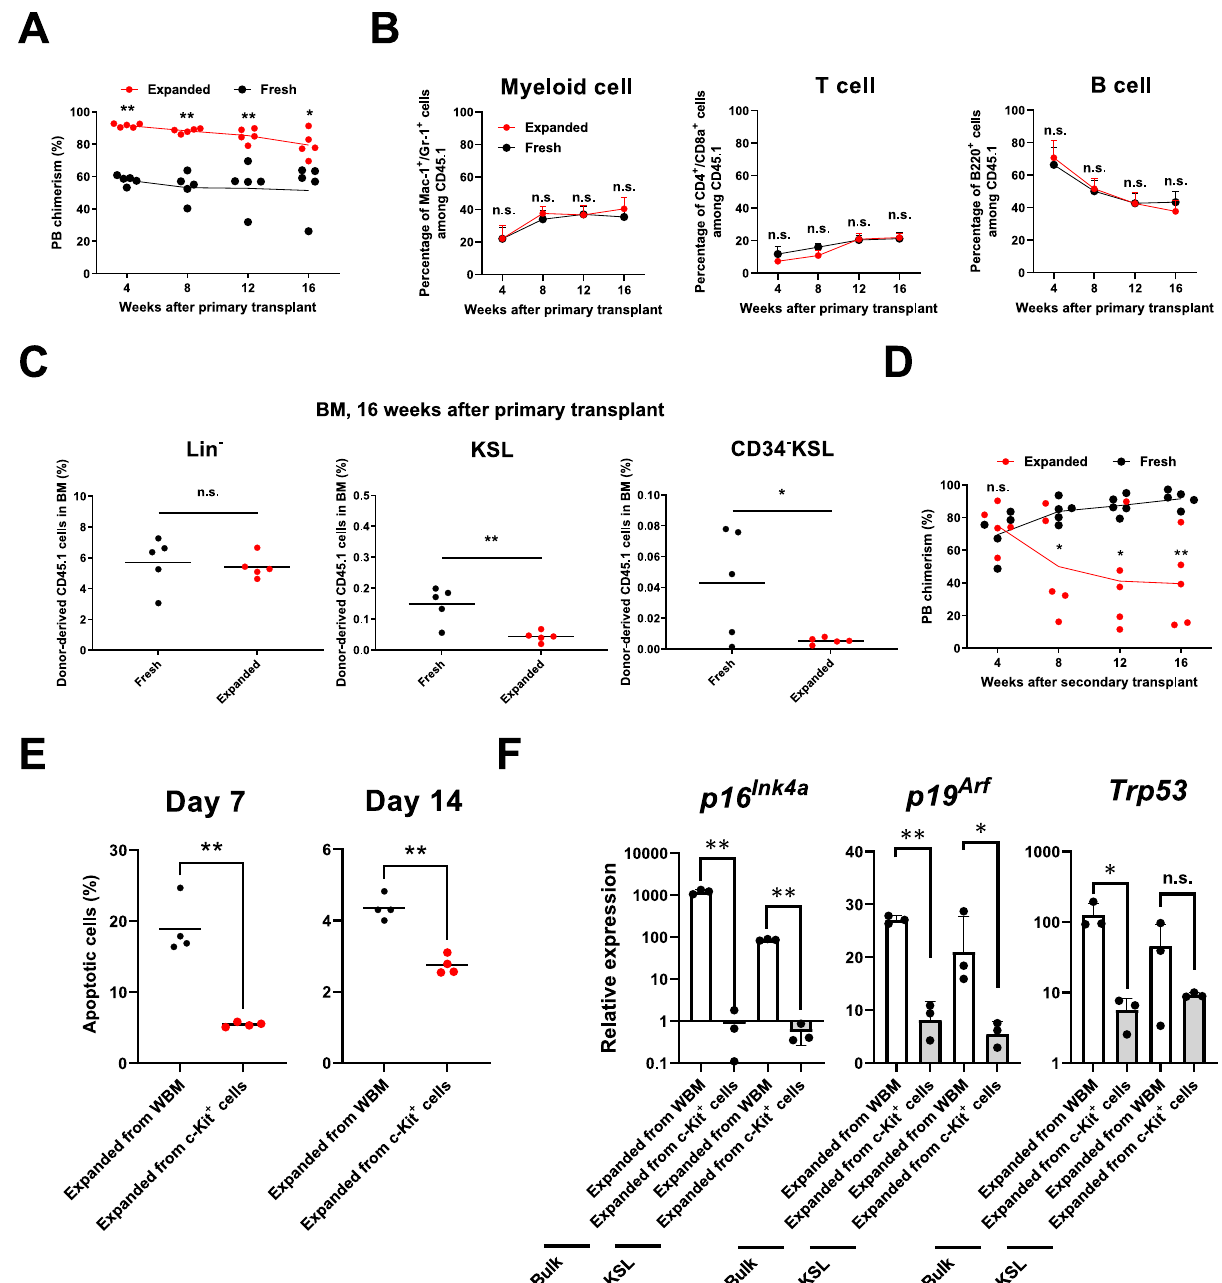
Fig. 2 Ex vivo enrichment of HSPCs from whole BM cells. A Percentage of donor-derived CD45.1 + cells in primary transplant recipients over time ( n = 5 mice per group) following competitive transplantation of 1 × 10 6 fresh or 28-day cultured whole BM cells (same transplantation protocol as detailed in Fig. 1A). ** p < 0.0001 at week 4, ** p < 0.0001 at week 8, ** p = 0.0013 at week 12, * p = 0.0114 at week 16. B Percentage of Mac-1 + /Gr-1 + (myeloid cells), CD4 + /CD8a + (T cells), and B220 + (B cells) among donor-derived CD45.1 + cells in primary transplant recipients over time for the mice described in A . Mean ± SD from 5 primary recipients ( n = 5 mice per group). C Percentage of CD45.1 + BM Lin − , KSL, and CD34 − KSL cells at 16 weeks post- transplantation for the mice described in A ( n = 5 mice per group). ** p = 0.0043 in KSL, * p = 0.0142 in CD34 − KSL. D Percentage of donor-derived CD45.1 + cells over time following secondary transplantation using the mice described in A ( n = 5 mice per group). p = 0.6265 at week 4, * p = 0.0459 at week 8, * p = 0.0107 at week 12, ** p = 0.0024 at week 16. E Percentages of Annexin V + /Propidium iodide (PI) + from day 7 and day 14 cultured whole BM or c-Kit + BM cells. Mean ± SD of 4 independent cultures ** p = 0.0004 at Day7, ** p = 0.0003 at Day 14. F Evaluation of gene p16 Ink4a , p19 Ar f and Trp53 expression in 7-day cultured whole BM or c-Kit + BM cells (RNA isolated from bulk and phenotypic KSL cells). Mean of three independent cultures, with gene expression normalized to Gapdh expression. Error bar denote SD. p16 Ink4a : ** p = 0.0001 (bulk cells expanded whole BM vs c-Kit + cells), ** p < 0.0001 (KSL expanded from whole BM vs c-Kit + cells), p19 Ar f :** p = 0.0008 (bulk cells expanded from whole BM vs c-Kit + cells), * p = 0.0203 (KSL expanded from whole BM vs c-Kit + cells), Trp53 : * p = 0.0218 (bulk cell expanded from whole BM vs c-Kit + cells), p = 0.2424 (KSL expanded from whole BM vs c-Kit + cells). Statistical signi fi cance was calculated using an unpaired two-tailed t -test, * p < 0.05, ** p < 0.01; n.s. not signi fi cant.